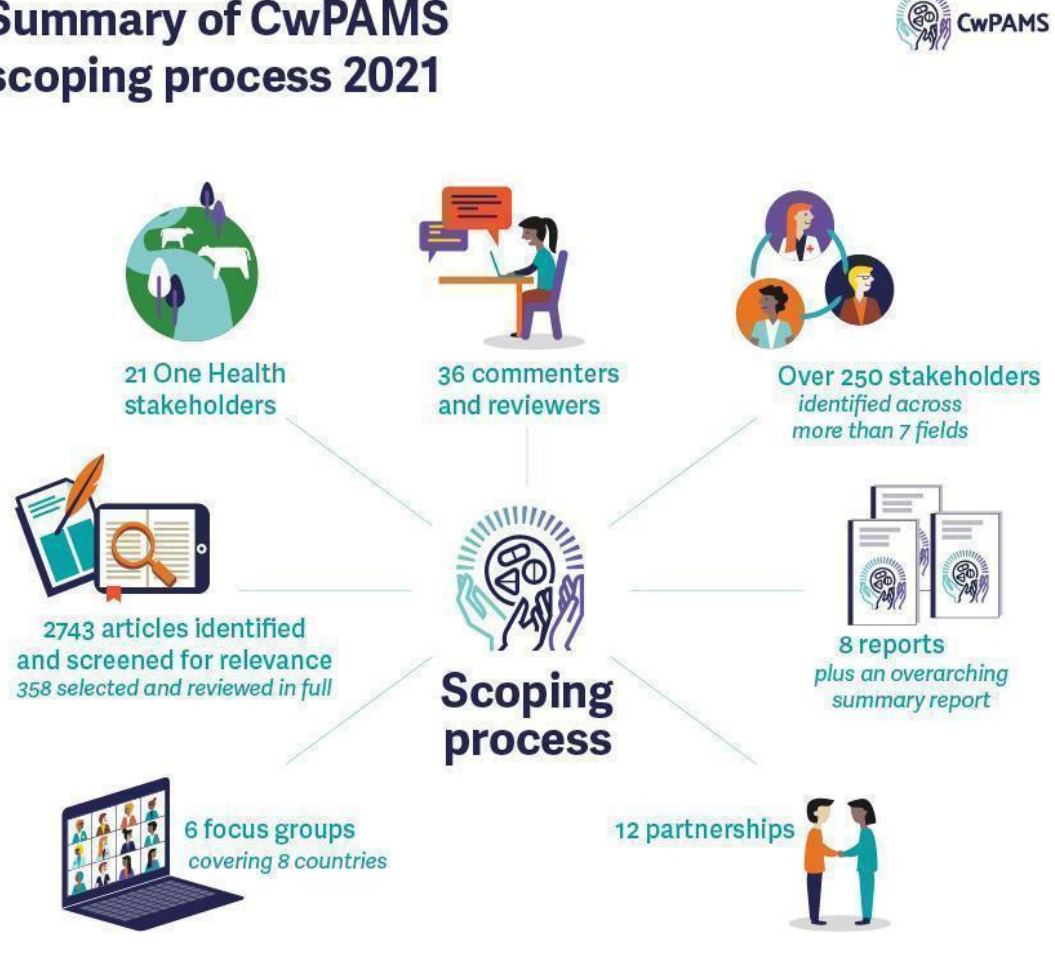
Figure 1. Summary of CwPAMS scoping